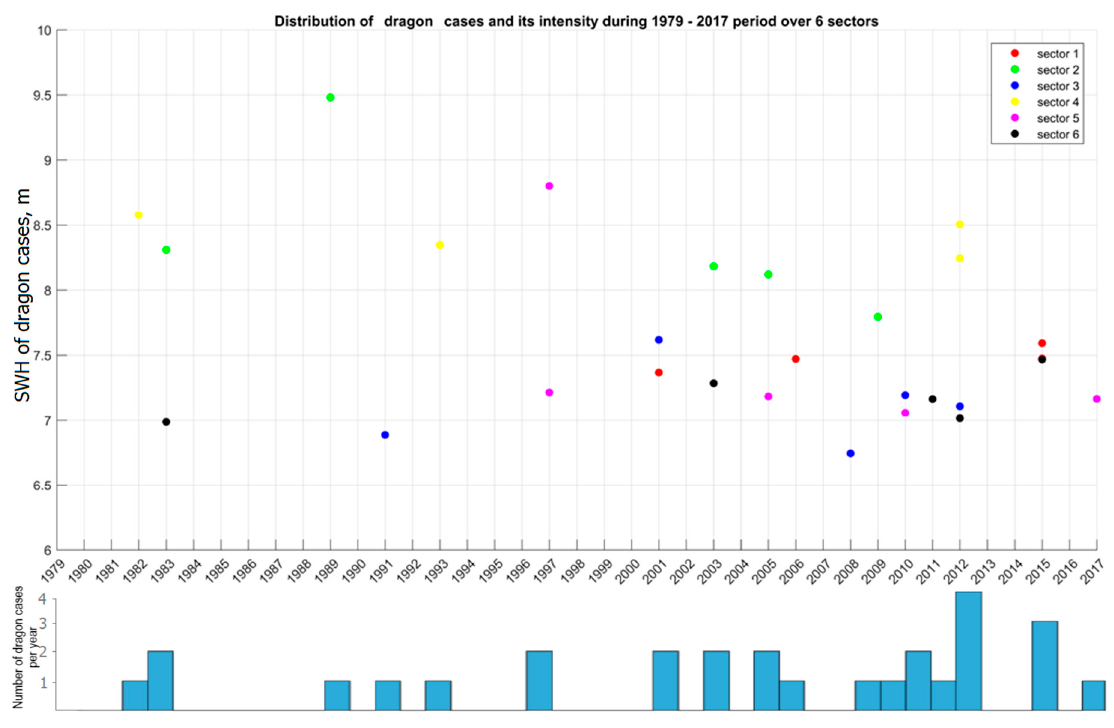
Figure 15. Cases of extreme events (“dragons”) from 1979 to 2017 for all sectors of the Kara Sea.